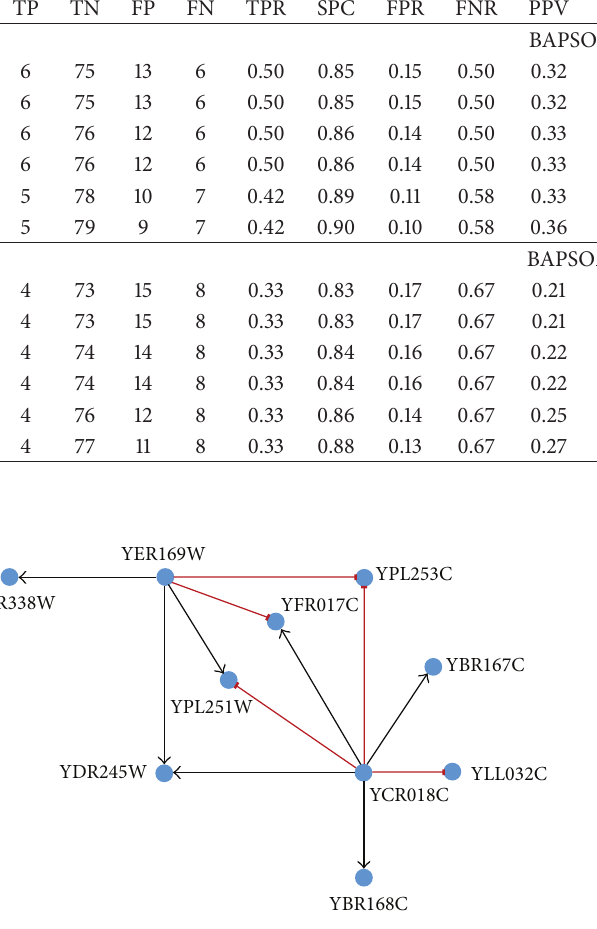
Figure 6: Network architecture extracted from GNW to validate the proposed framework as used in [46].